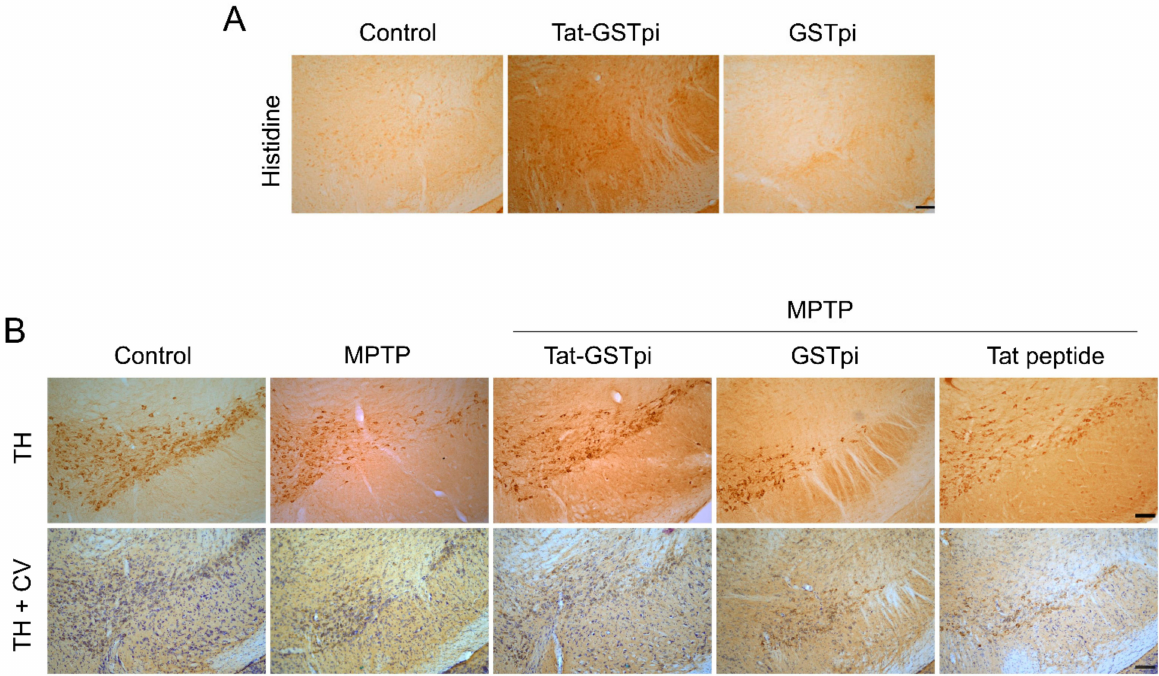
Figure 6. Effects of Tat-GSTpi proteins in an MPTP-induced PD animal model. ( A ) Delivery of Tat-GSTpi protein to the SN of mice brain. Tat-GSTpi protein or GSTpi protein was injected